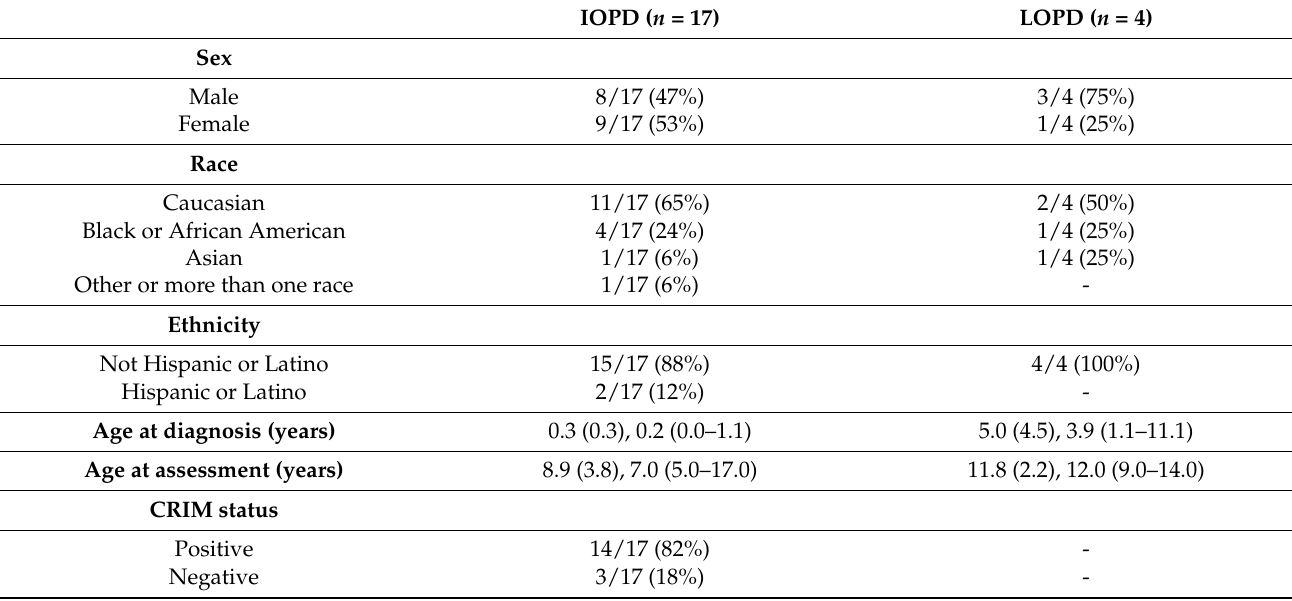
Table 1. Baseline characteristics. Categorical variables presented as n , (%). Continuous variables presented as Mean (SD), median